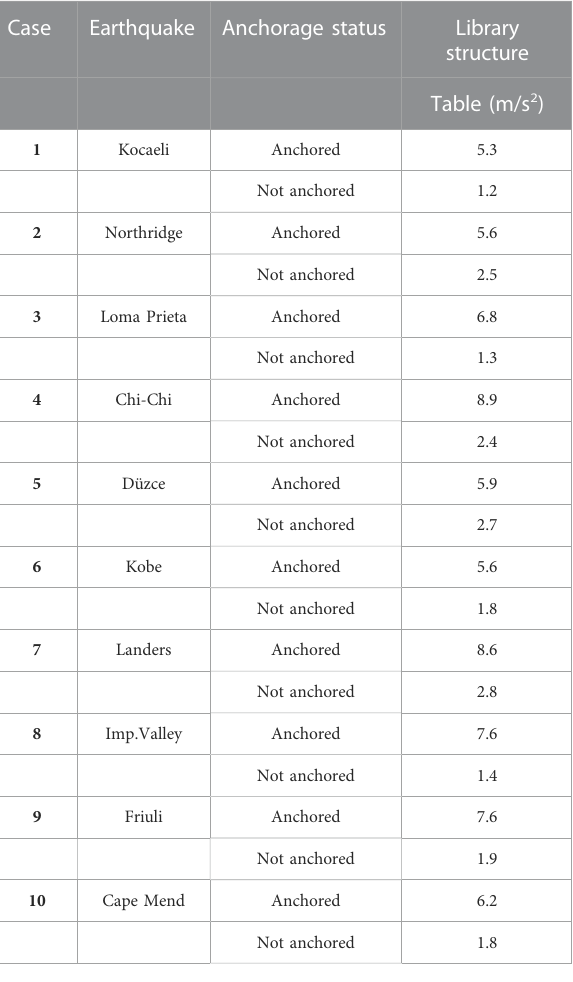
TABLE 5 Maximum seismic displacement results for different NEs (Cavuslu,